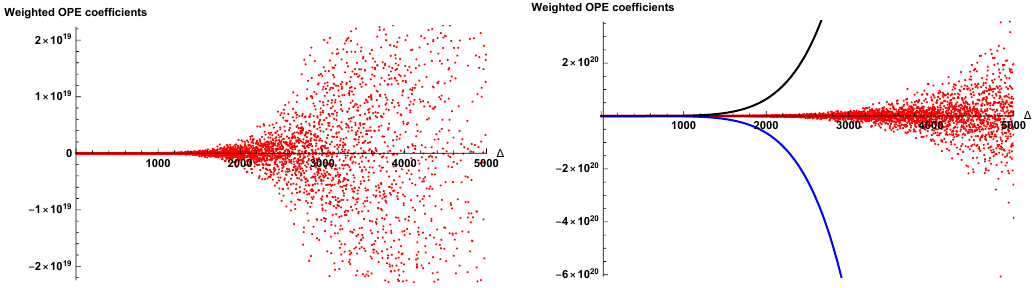
Figure 2 . q expansion coe(cid:14)cient of the torus one point function of (cid:10) 12 (cid:15) = (cid:17) 24 and the fact that j b N j is bounded by N 6 , denoted by the black and blue